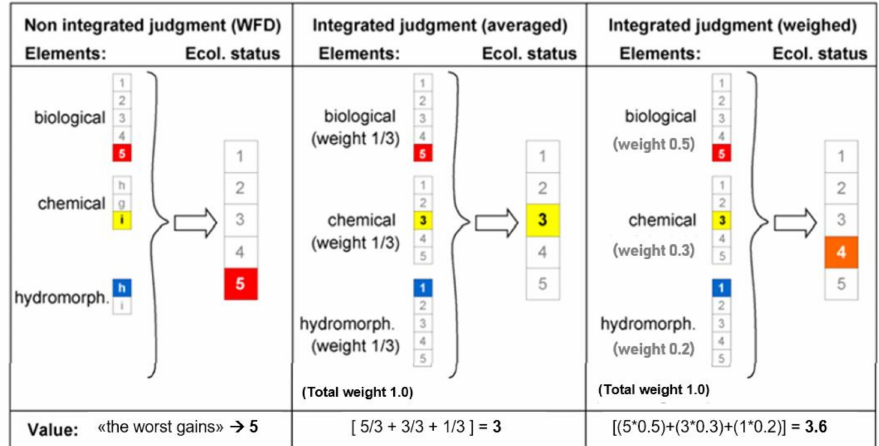
Figure 9. Examples of poor internal coherence through a comparison of different classification criteria for the ecological status. Left: the WFD criterion is “incoherent” because, based on the “worst prevails” dilemma, it produces the same value (5) and the same judgment (“bad”) for the situation shown, as well as for other situations that are undoubtedly superior (e.g., chemical–physical elements in class h = high or g = good) or worse (e.g., hydro-morphological elements in class i = inferior). Middle: admitting compensation amongst attributes, and a weighted average aggregation with the same weights (1/3), the overall value obtained is 3 (moderate). Right: the same approach, but with different weights (0.5 for the biota component, 0.3 for the chemical-physical, and 0.2 for the hydro- morphological), produces a slightly higher value that leads to a higher quality class (4). (Courtesy of the Italian Journal Biologia ambientale ; original author Giuseppe